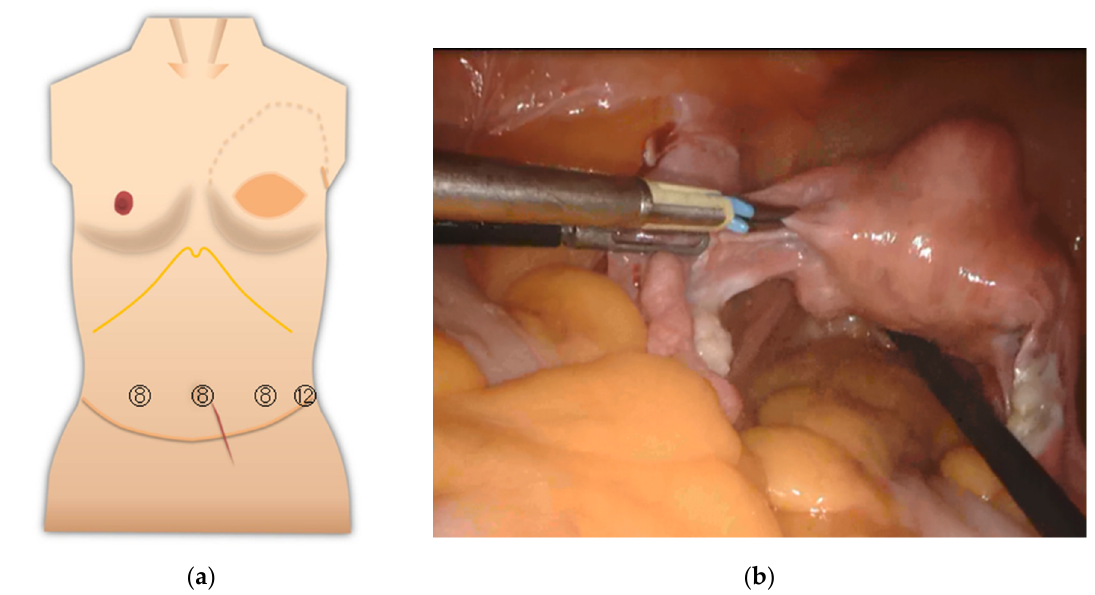
Figure 3. ( a ) Port layout of Case 1. The circled numbers indicate the port diameter (mm, the same applies to the following Figures). The blue line is an incision line; ( b ) view of the pelvic